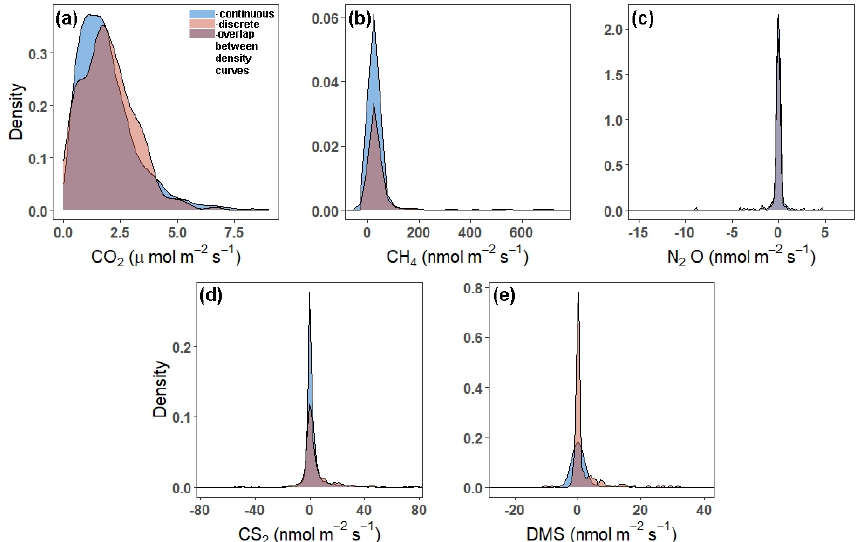
Figure 4. Density plots comparing the distribution of fluxes throughout all campaigns (continuous over ∼ 72h) to those measured during daytime low tide (discrete, 1 h before and 1 h after daytime low tide) for (a) CO 2 , (b) CH 4 , (c) N 2 O, (d) CS 2 , and (e) DMS. Note that the scales on the x - and y axes are different. The tails have been cut off to better see the peaks for (b) , (c) , (d) , and (e) . For plots with full distributions, see Fig. S2.